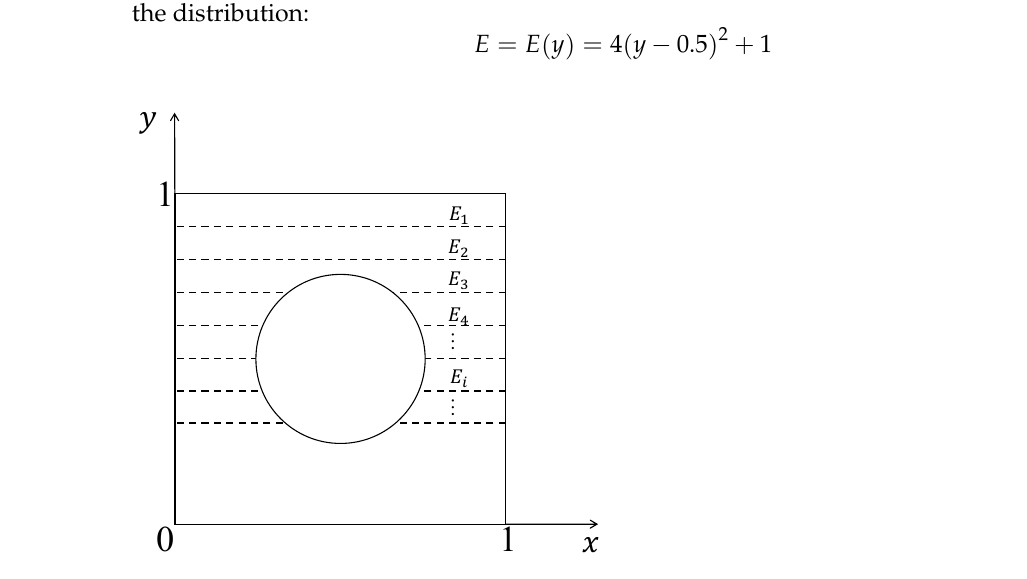
Figure 12. Schematic diagram for E n uniformly distributed in the y direction. As seen from Equation (14), the modulus followed a quadratic distribution in the y direction. To solve this problem, we adopted a method of solving for the Poisson’s ratio, which is not discussed here for brevity. The converged E n after inversion is shown in Figure 12. The circle, square, and triangle marks represent the results derived from the PINN with the values of n set as 5, 10, and 15, respectively. The black line represents the exact solution obtained from Equation (14). The convergence curve of the training for this model is similar to that of the Poisson example and is thus not presented here. From Figure 13, it is apparent that the three inversion results showed good agreement with the true result and were all capable of reflecting the distribution pattern of the true modulus. On the whole, it can be observed that when n = 10, the degree of agreement between the inversion results was higher, which is highly consistent with the conclusion obtained from the inversion of the Poisson ratio distribution mentioned earlier. This example serves as further evidence of the powerful ability of PINNs in dealing with inverse problems.